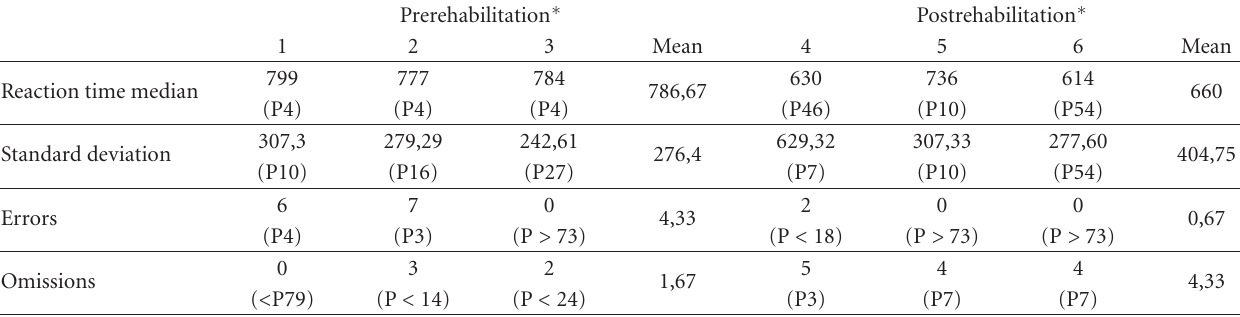
Table 5: G. O.’s results on the control task (divided attention task).